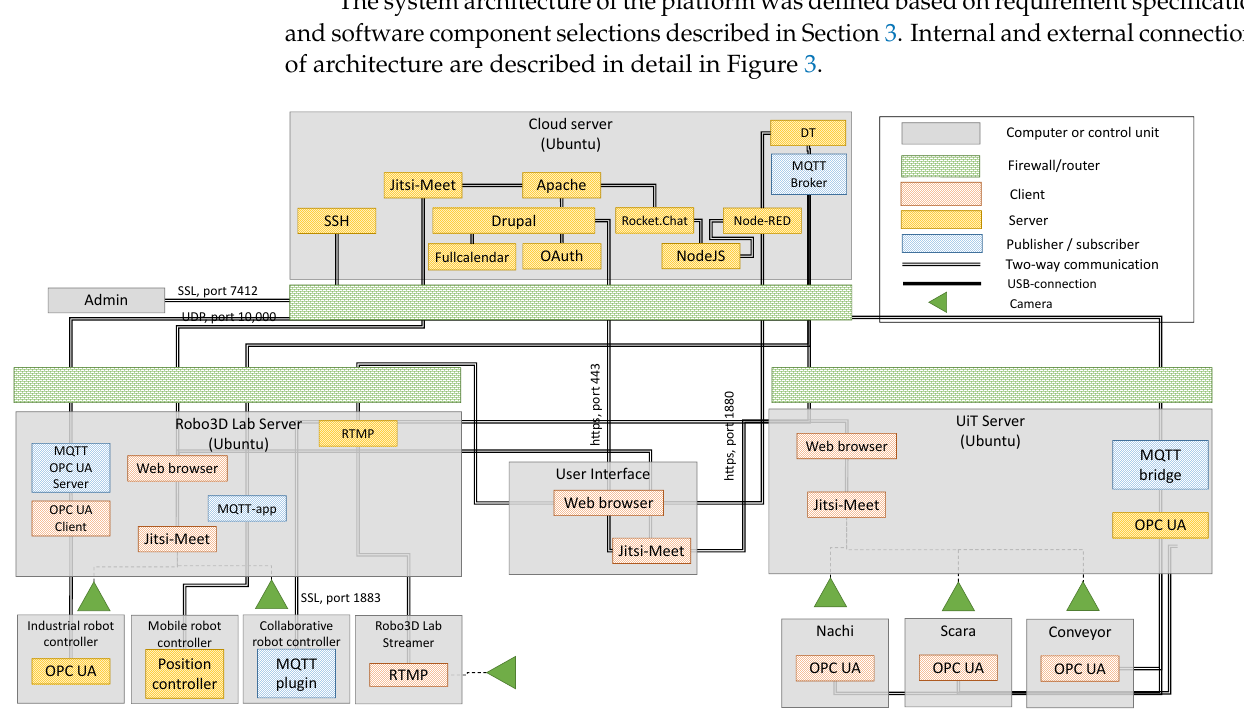
Figure 3. Platform internal and external